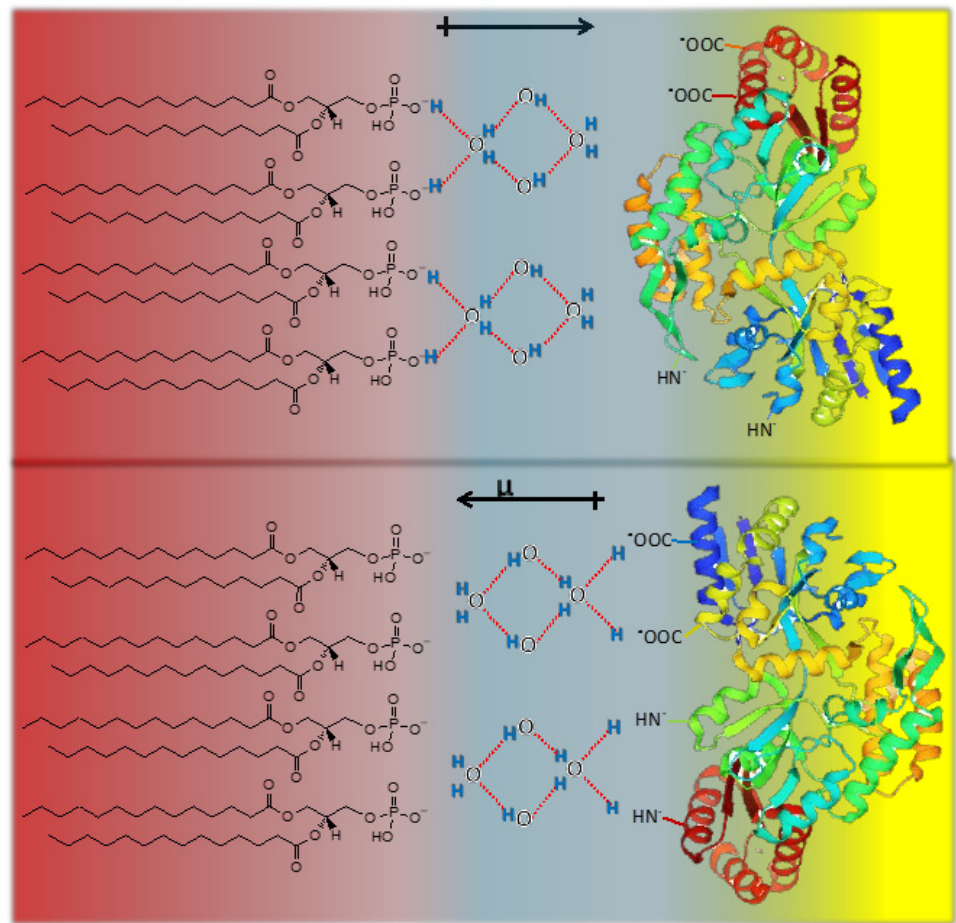
Figure 5. Inversion of dipole direction by displacement of protons without molecular rotation. Protein conformation may change inducing a water polarization by proton displacement that propagates to the membrane interphase and vice